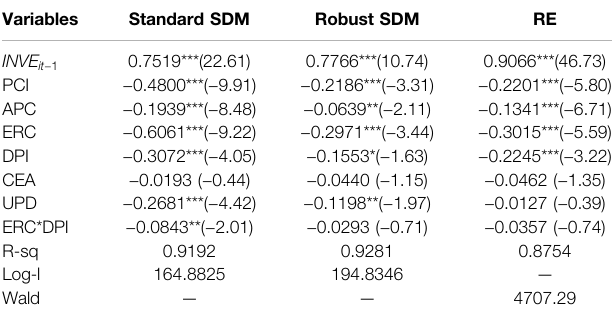
TABLE 11 | Robustness tests (INVE2).